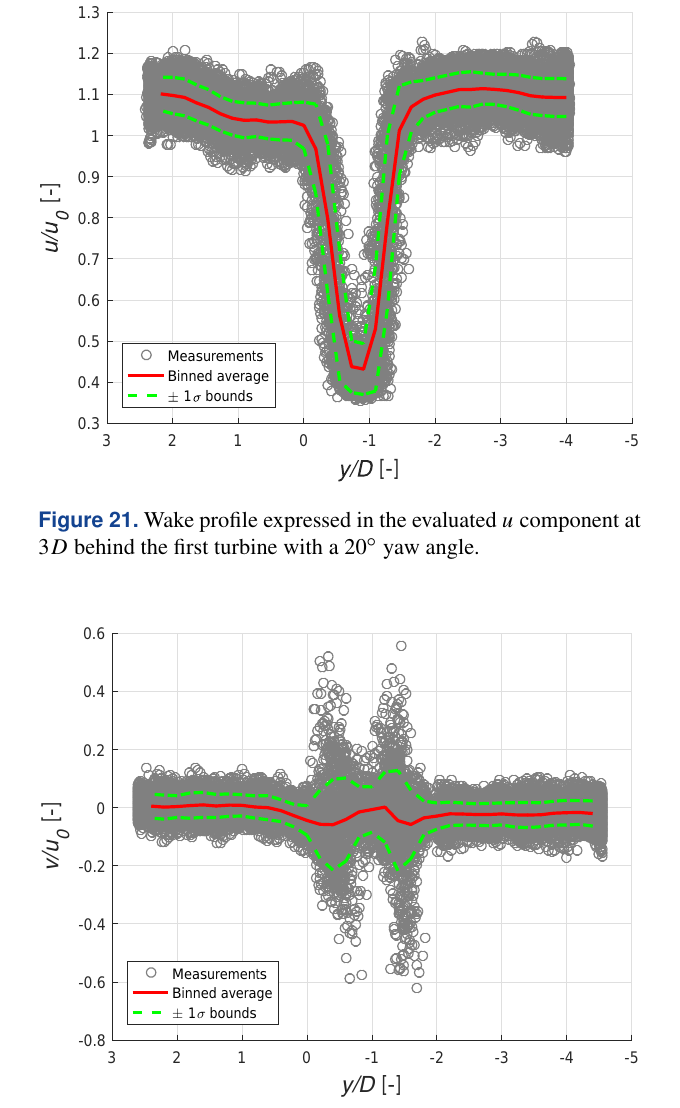
through Eq. (1), are plotted in Figs. 24a and b, respectively. They illustrate that the lidars are capable of determining the 2-D flow across a horizontal wind turbine wake cross section. The plot of the u components shows a smooth and overlap- ping triple wake enabled by the low turbulence in the wind tunnel. The non-zero local v components indicate the initial flow expansion in the induction zone of each of the turbines. These effects are clearly visible in the upper part of the plot, whereas in the lower part of the wake these effects are aver- aged out due to the larger turbulence in the region where the wakes from the three turbines partly overlap. Some artefacts can be seen in the background of Fig. 24b, probably caused by